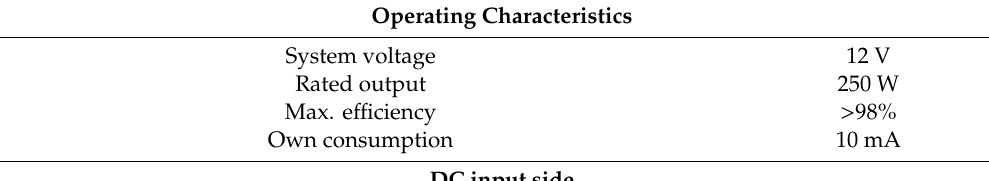
Table 2. Parameters of solar charge controller with maximum power point tracking